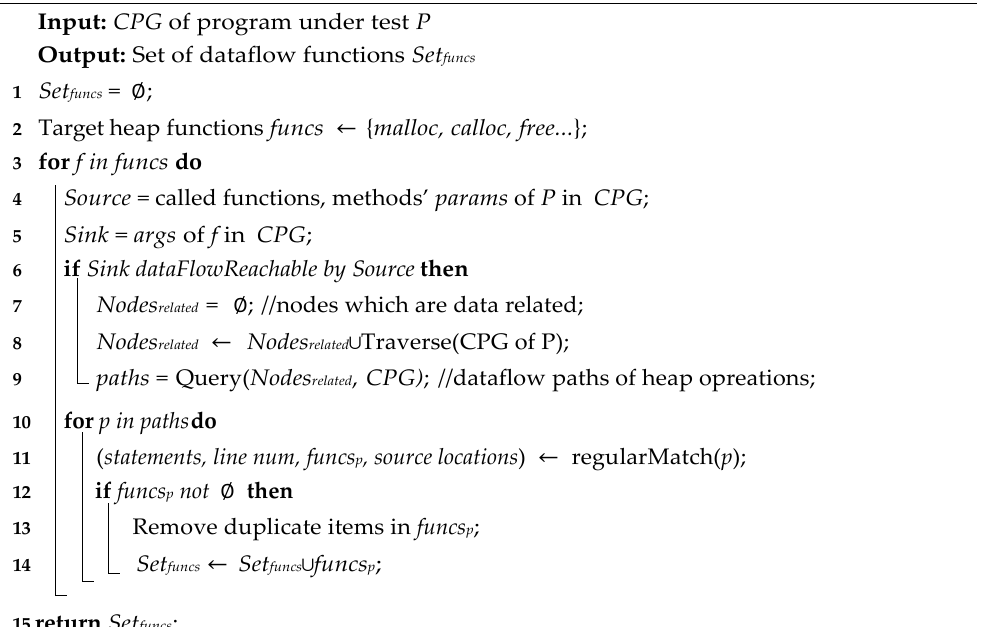
Algorithm 1: Taint analysis approach for locating potentially vulnerable functions Algorithm 1 : Taint analysis approach for locating potentially vulnerable functions